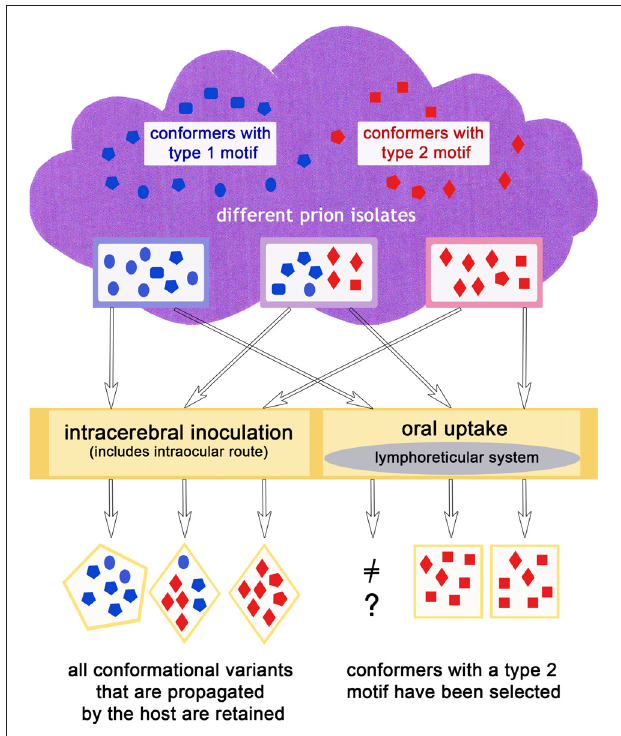
FIGURE 3 | The infection route could influence the outcome of the dominating conformers in the same or a different host species, if for example, an oral uptake leads to a preferred propagation of type 2